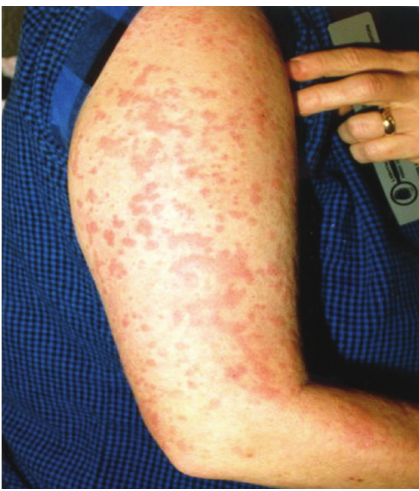
Figure 1: Characteristic salmon colored, nonpruritic, and maculo- papular rash of Still’s disease (source: http://www.stillsdisease.org/).